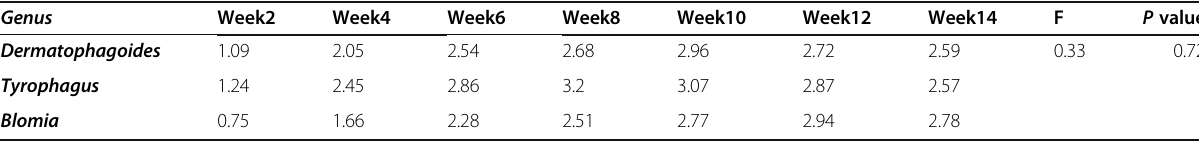
Table 1 Log of cultivated mites counts in pure cultures and statistical analysis Genus Week2 Week4 Week6 Week8 Week10 Week12 Week14 P value